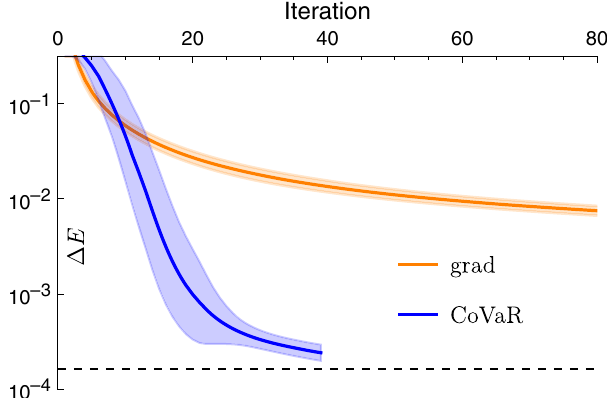
FIG. 12. Comparison of the performance of CoVaR to gradient descent when starting from a point close to the ground state of the ten-qubit spin chain, analogous to Fig. 7(c) for recompilation. This initialization is done by randomly perturbing the parameters of a state close to the ground state. Average initial fidelity to the ground state is F ¼ 80 (cid:4) 4% . Mean and standard deviation are shown for 20 runs of gradient descent and the 16 = 20 runs of CoVaR that converge to the ground state rather than one of the excited states. The Ansatz can only approximate the ground state of the spin model; the grid line at Δ E ≈ 1 . 6 × 10 − 4 marks the minimum achieved energy as the limit of precision. One can further improve Δ E by only increasing the Ansatz